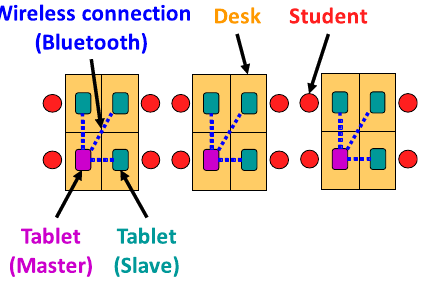
Fig. 14 Environment for evaluation of the educational application